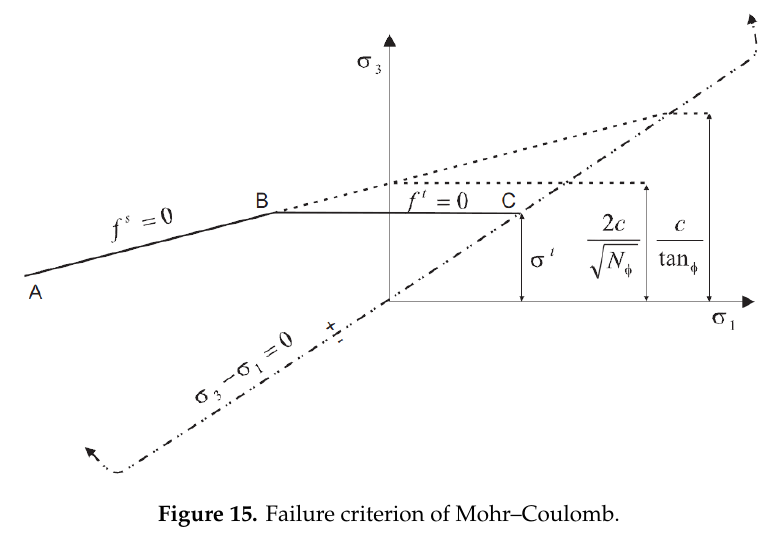
Figure 15. Failure criterion of Mohr–Coulomb.